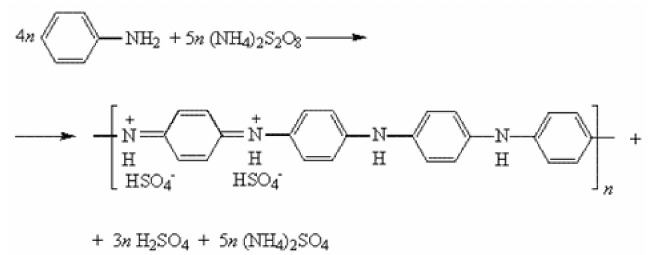
Figure 1. The scheme of oxidative polymerization of